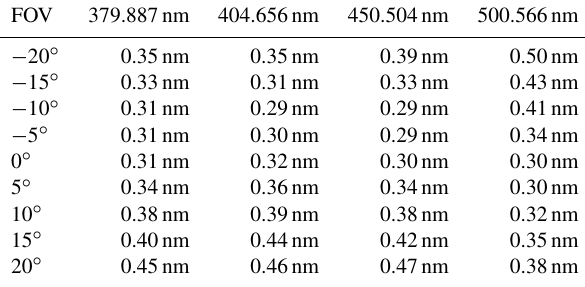
Table 2. Preflight wavelength calibration results (full width at half maximum values; FWHMs) of UVHIS channel 3 for nine view- ing angles. Light sources used in the calibration are a mercury– argon lamp and a tuneable laser. Slit function shapes are retrieved by least square fitting of characteristic spectral lines, using a sym- metric Gaussian